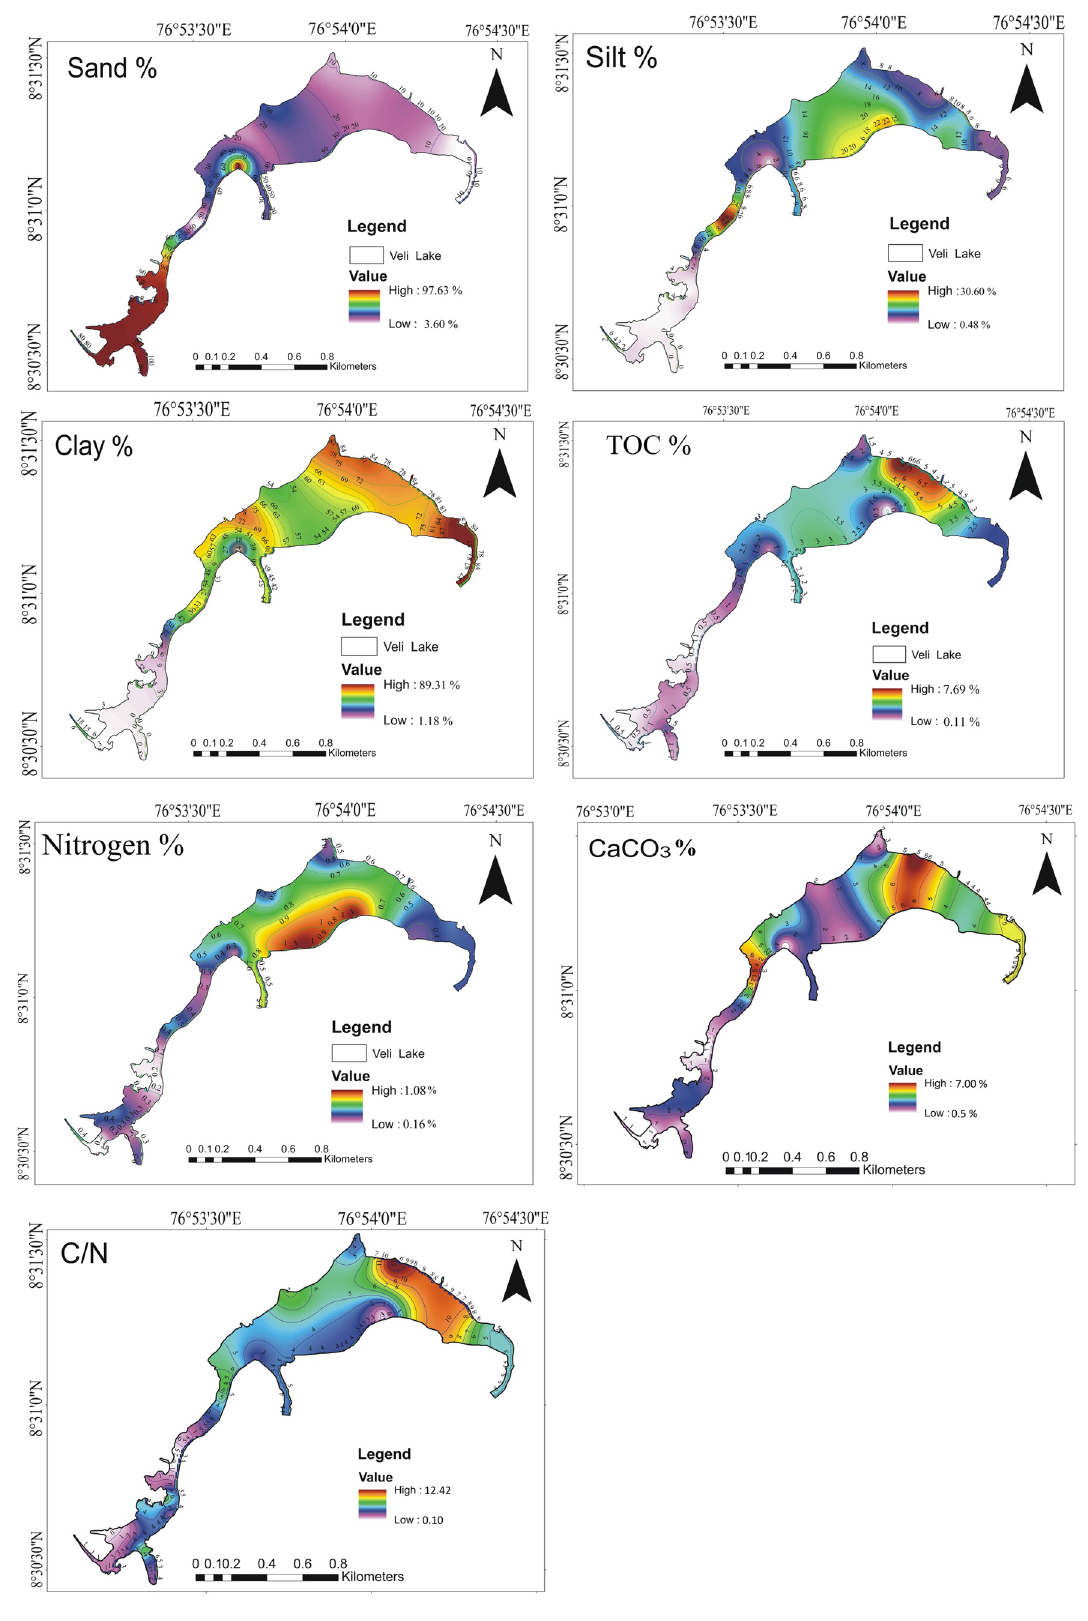
Fig. 3 Special distribution of sand, silt, clay, TOC N, CaCO